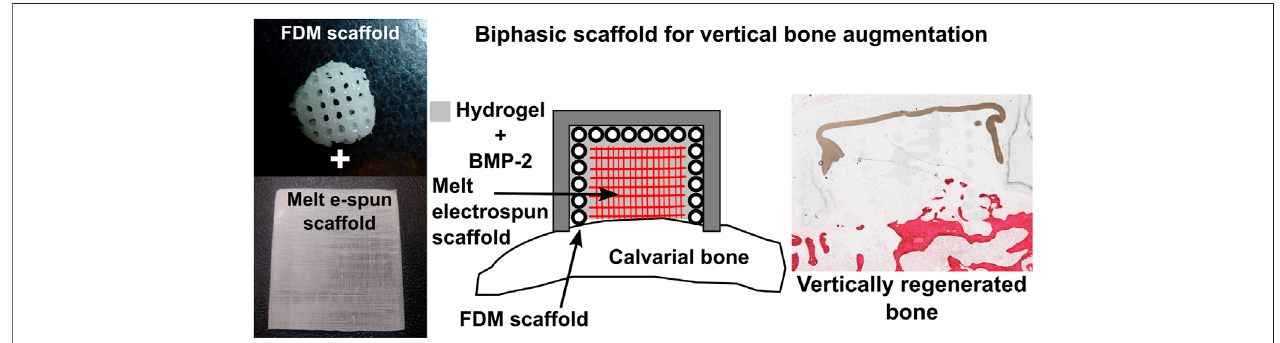
FIGURE 7 | Additively manufactured biphasic scaffold for vertical bone augmentation using a biodegradable polymer, polycaprolactone loaded with a hydrogel. Reproduced with permission from (Sudheesh Kumar et al., 2018).